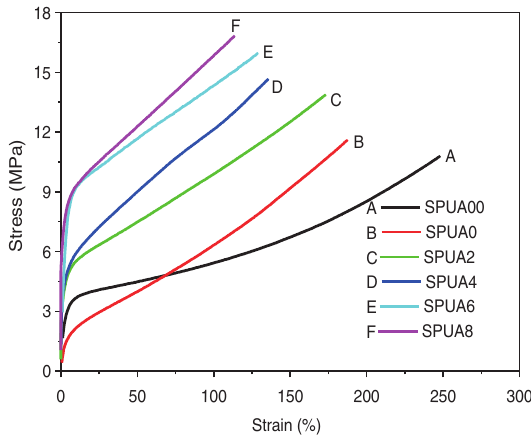
Figure 8: Stress-strain curve of SPUA films with different TEOS weight %.